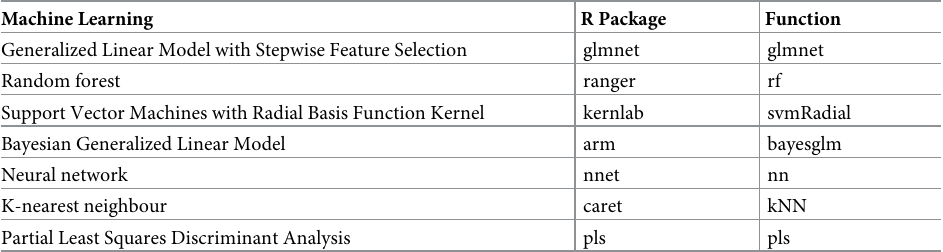
Table 3. The seven machine learning methods used to predict tail biting events from feeding behaviour